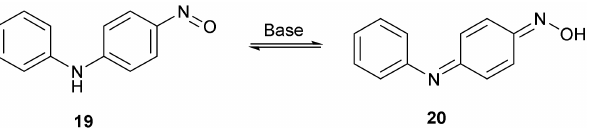
Figure 6. The base-catalysed tautomerism of 4-nitrosodiphenylamine to an oxime.